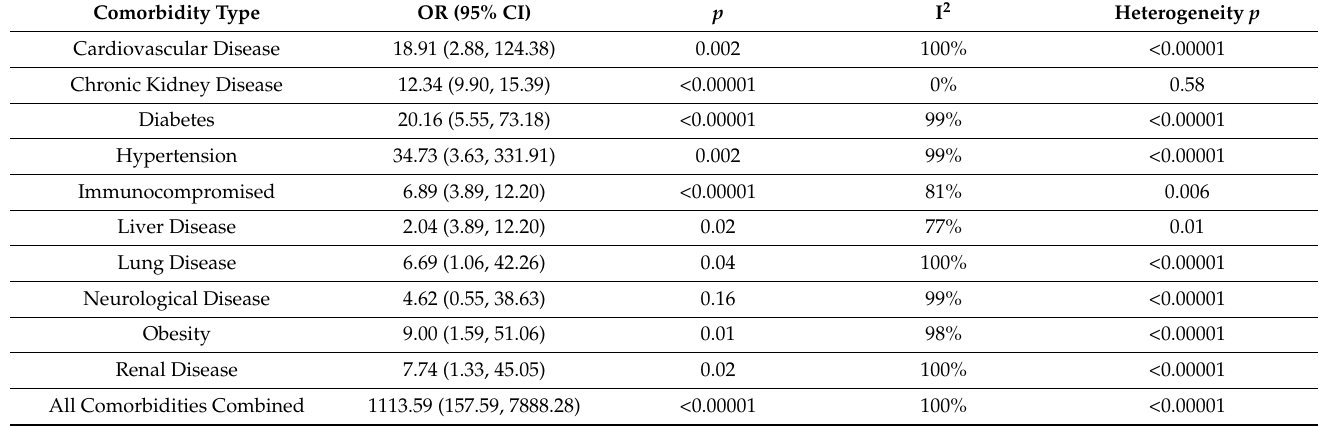
Figure 3. Summary of the mortality risks by COVID-19 comorbidities. Table 1. Summary of the odds ratio outcomes.